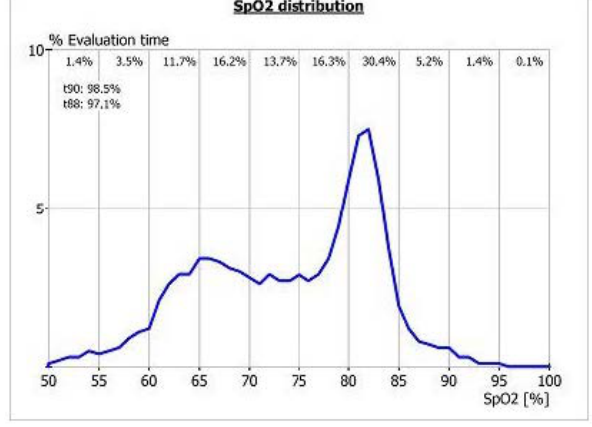
Chart 3. Overview of the polysomnographic SpO2 variations during examination time.